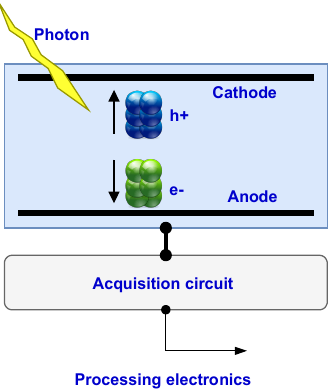
Figure 7. Schematic representation of a CZT-based imaging system.